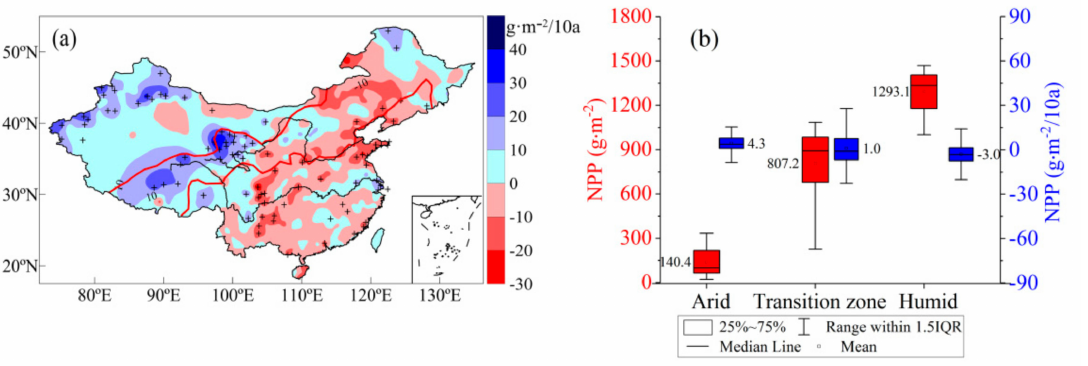
Figure 8. NPP trend (1960–2017) and ( a ) distribution of average values and trends in sub regions and ( b ) +indicates that the trend was significant at the 0.05